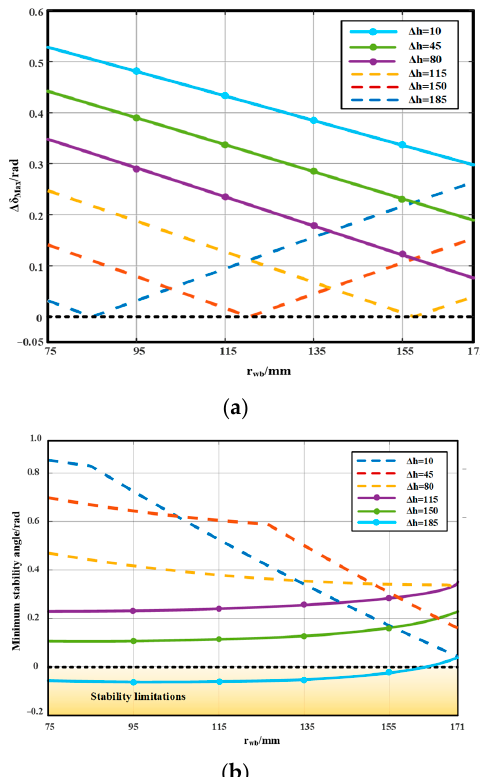
Figure 16. Single wheeled leg overrun stability analysis. ( a ) Robot cross-roll angle variation graph; ( b ) robot stability criterion change graph.